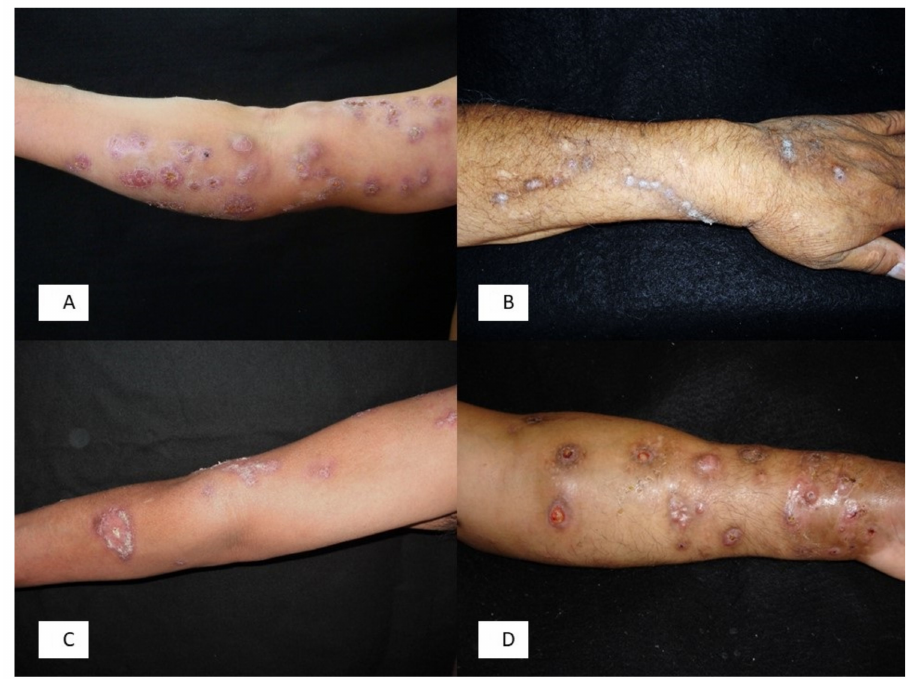
Figure 2. ( A ) Lymphatic sporotrichosis; ( B ) Chromoblastomycosis due to Rhinocladiella aquaspersa ; ( C ) Mycobacterium marinum infection; ( D ) Actinomycetoma due to Nocardia brasiliensis